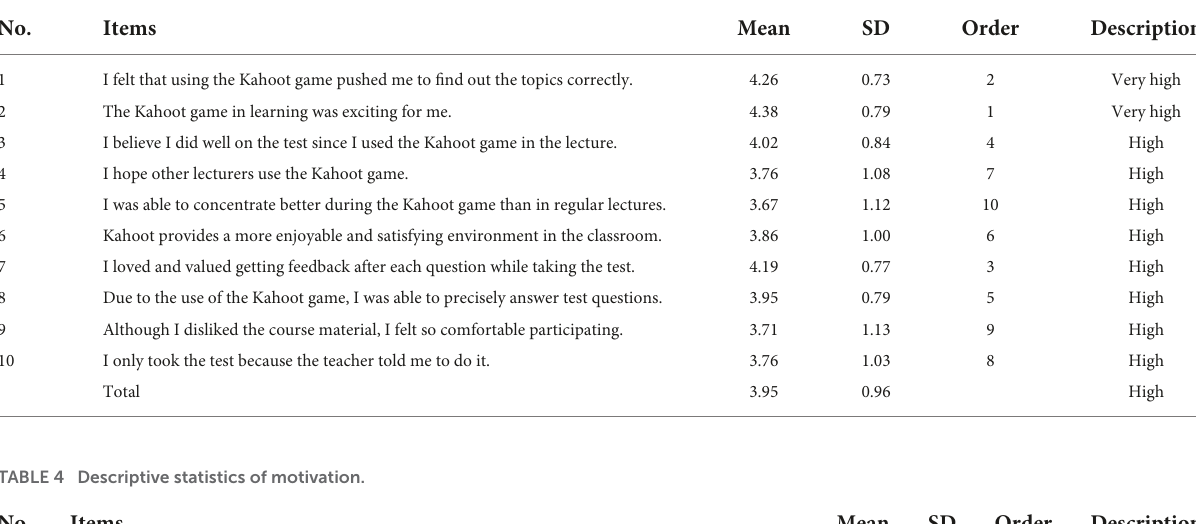
TABLE 3 Descriptive statistics of engagement.